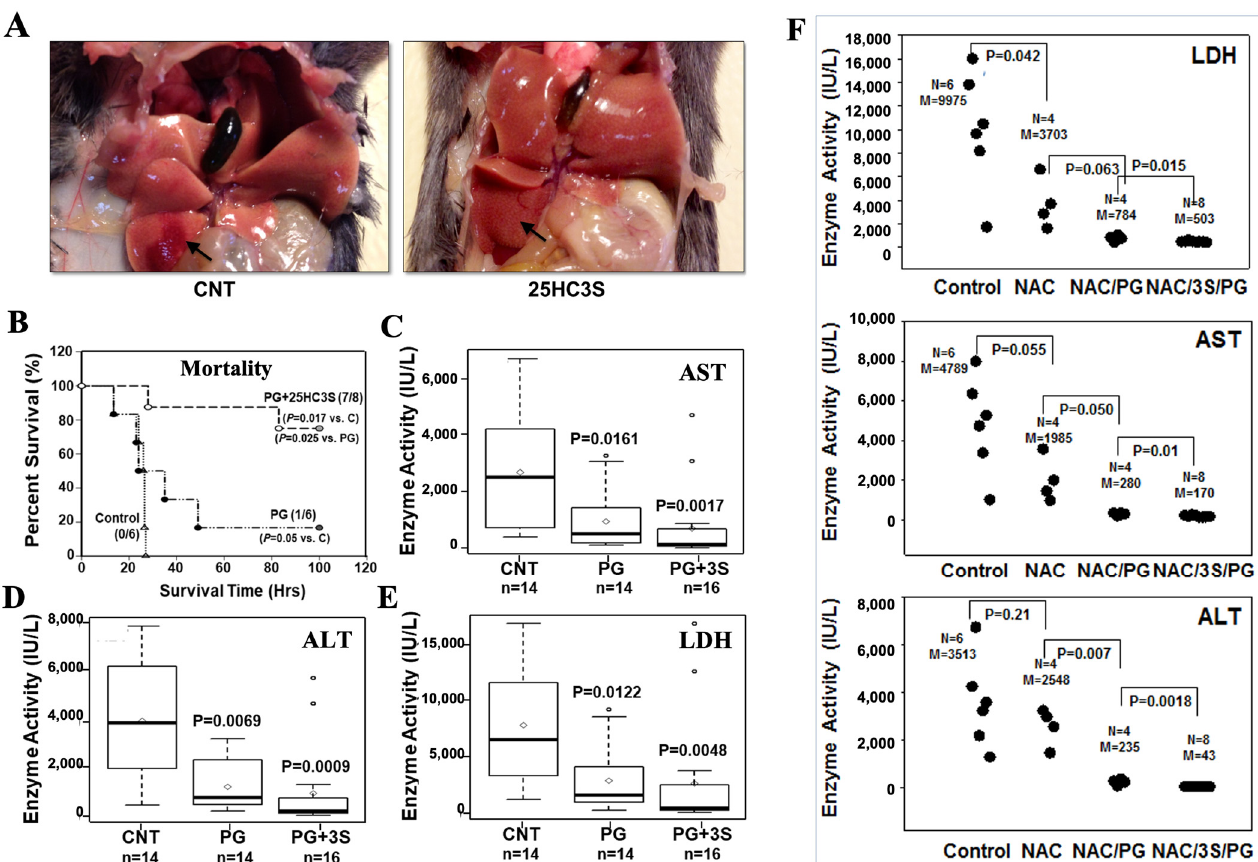
Figure 1. 25HC3S treatment improves organ function and survival rates in APAP overdose mice. 12-week-old female C57BL/6J mice were administered either with control ( n = 6), vehicle ( n = 6) or 25HC3S ( n = 8) 2 h before APAP (600 mg/kg) treatment. ( A ) The gross observation of liver after treated with 25HC3S in mice. The arrow indicates the site of APAP induced liver injury. ( B ) Mouse survival rates was observed and recorded up to 100 h. ( C – E ) The mice were injected with 350 mg/kg APAP and after half hour mice were intravenously treated with 10% glucose in sterile water for the control group, vehicle (20% propylene glycol (PG), 4% hydroxypropyl- β -cyclodextrin (HBC) in 10% glucose/water) for the PG group, and 25 mg/kg 25HC3S in vehicle for the 25HC3S group, respectively. After 24 h, serum activities of AST, ALT, and LDH were determined by a clinical laboratory. CNT: represents control mice with APAP injection only; PG: represents vehicle with PG treated control mice; 3S: 25HC3S treated mice. Solid bar shows the average value of each group. ( F ) Effects of PG, 25HC3S in PG, NAC, NAC in PG, and NAC+25HC3S in PG on injured liver function using the models as shown